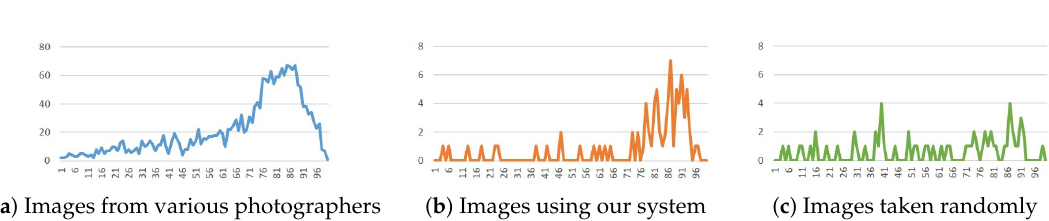
Figure 43. Results for the vanishing-point composition method.